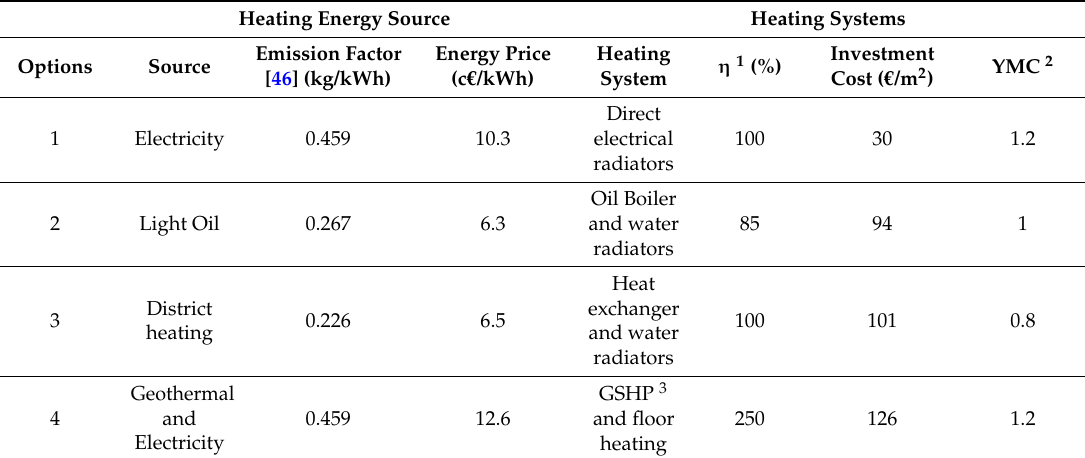
Table 8. Heating system